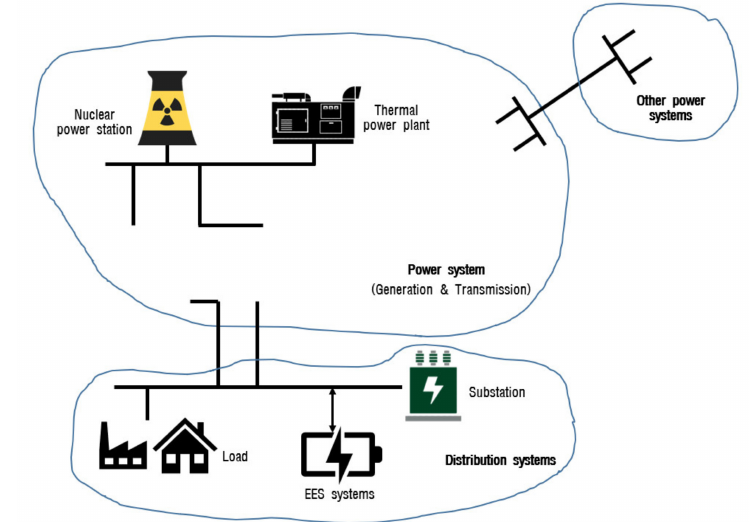
Figure 1. Power system with EES